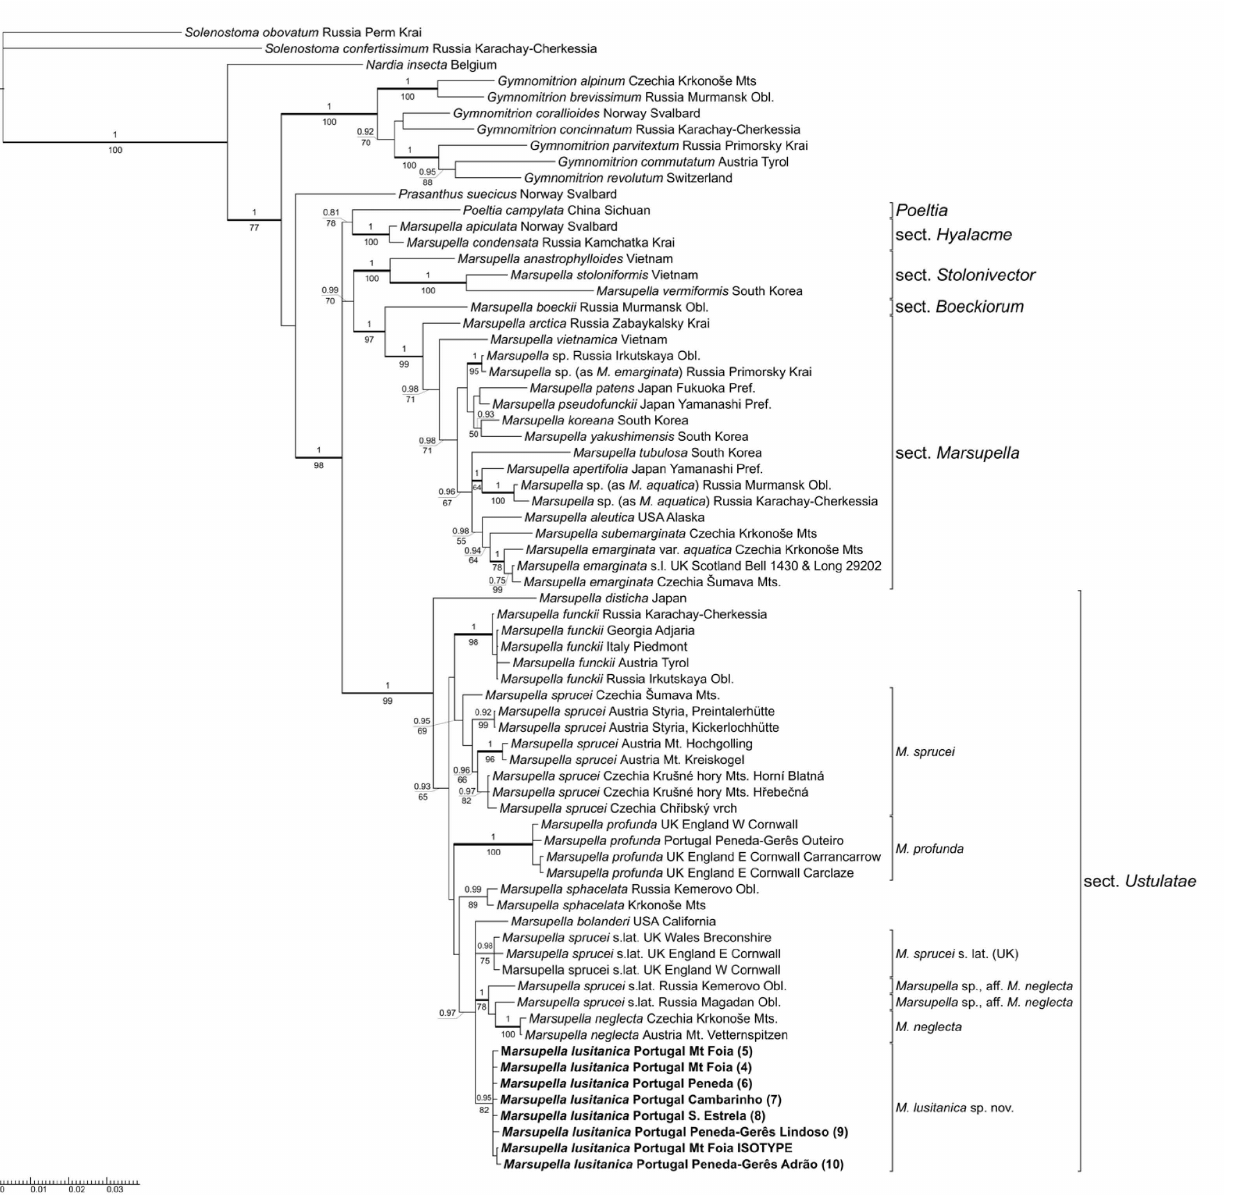
Figure 1. Consensus tree from the Bayesian inference of concatenated ITS and trnF–trnT data, partitioned between ITS and trnF–trnT nucleotide data and standard data from indels coded by a simple coding method [19]. Accessions of Marsupella lusitanica are printed in bold. Support values representing posterior probabilities from Bayesian analysis are plotted above branches, while bootstrap support values from Maximum Likelihood analysis of the equally partitioned dataset appear below branches. Support values are shown only on branches receiving either PP > 0.9 or BS > 70. Branches which received maximum support from at least one of the analyses and accessions of Marsupella lusitanica appear in